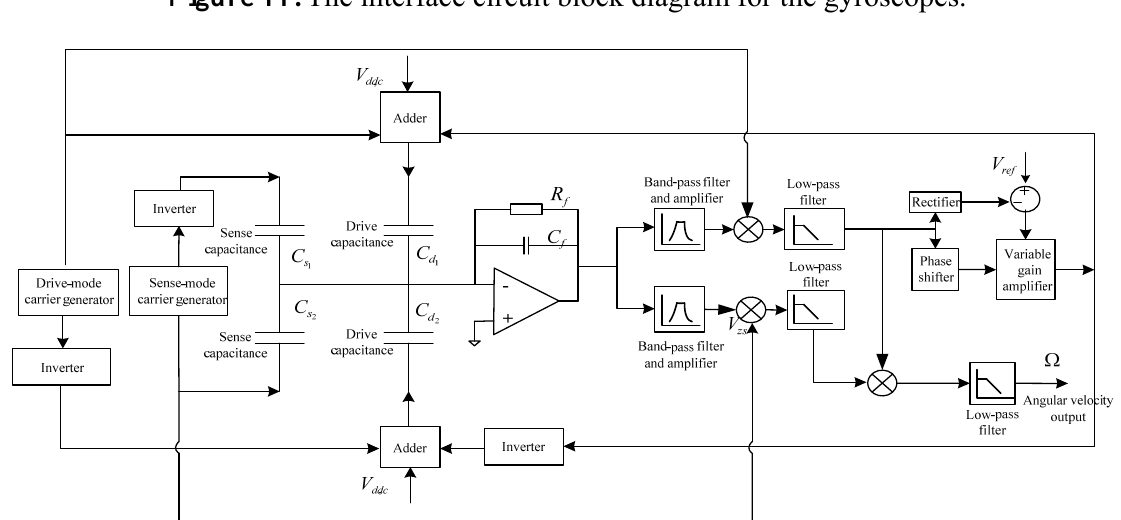
Figure 11. The interface circuit block diagram for the